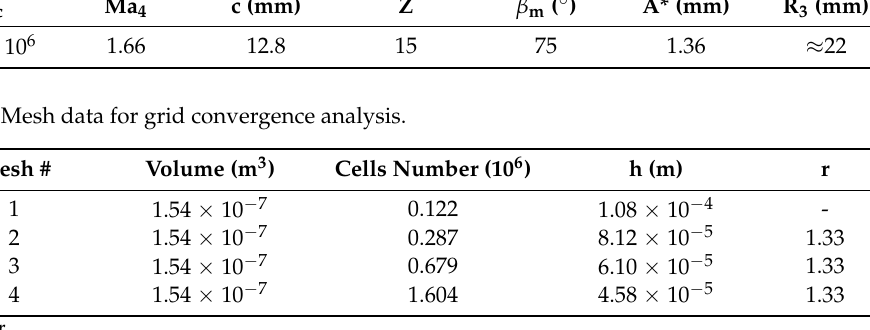
Table 1. Mesh sensitivity analysis vane features.